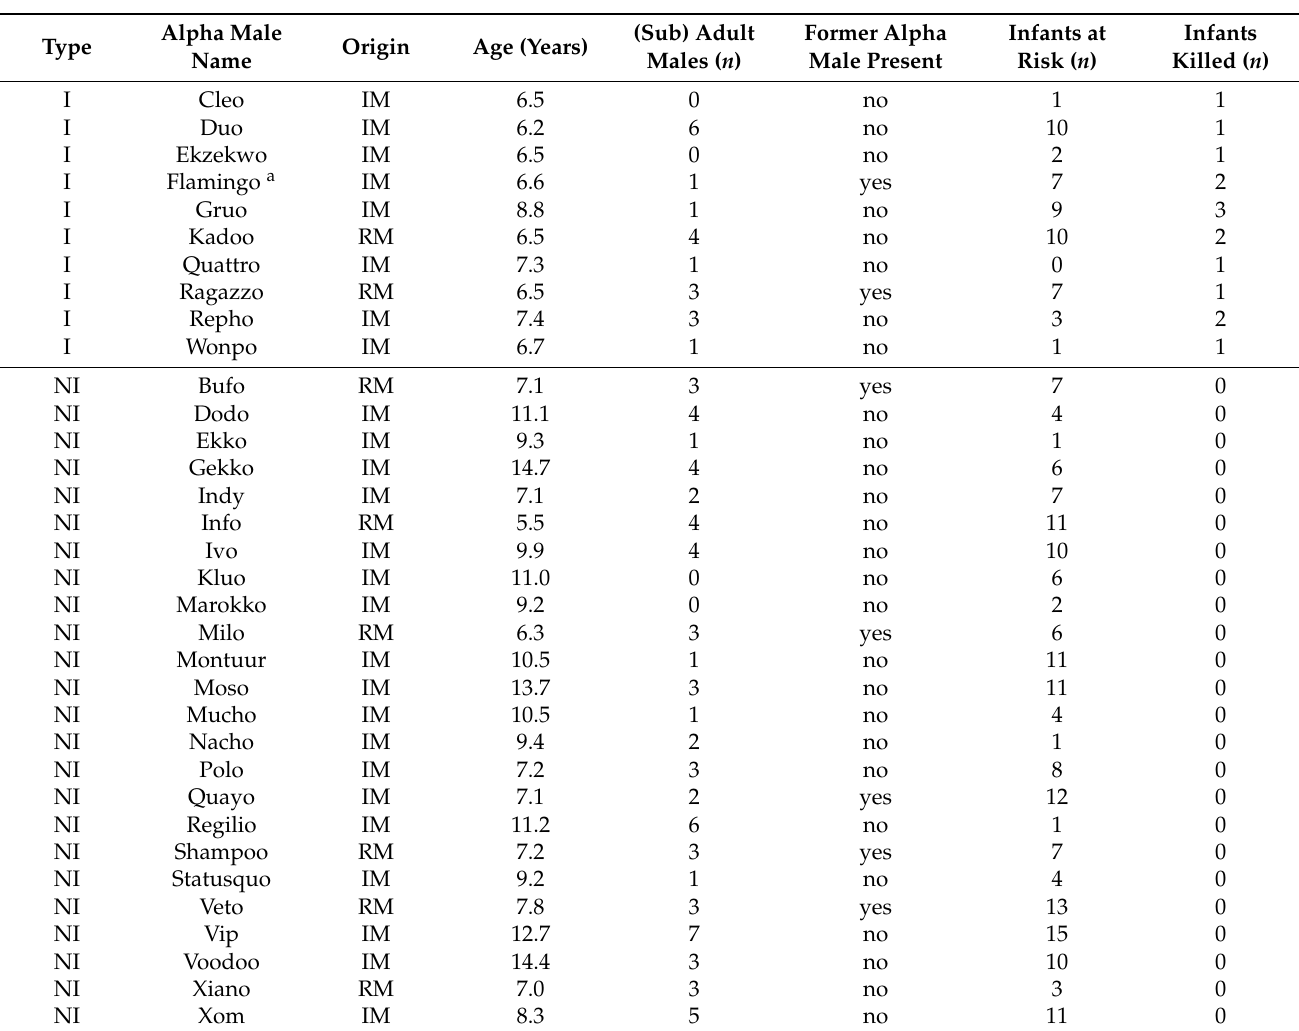
Table 1. Alpha male and group characteristics during new alpha male